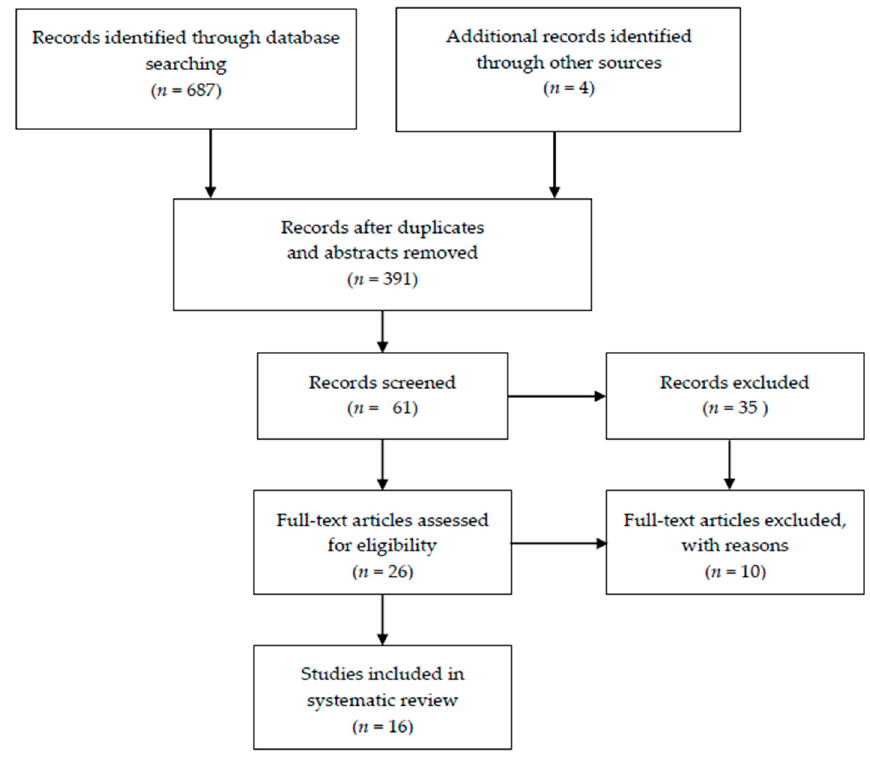
Figure 1. Preferred Reporting Items for Systematic Reviews and Meta-Analysis (PRISMA) flow diagram for the systematic review.